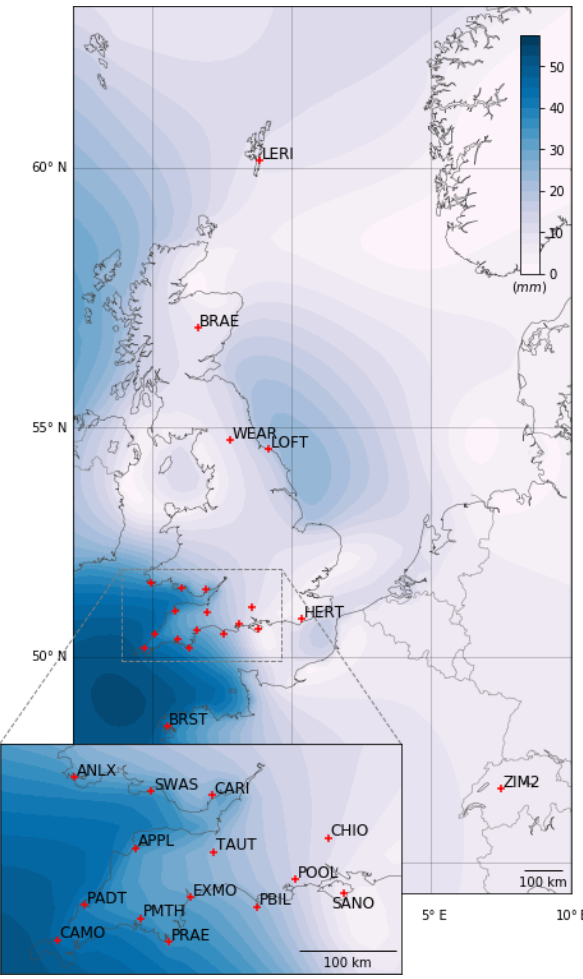
Figure 1. Map of the study area with GNSS site codes and M 2 up displacement amplitude in the background (TPXO7.2 ocean tide model and spherically symmetric Earth with PREM